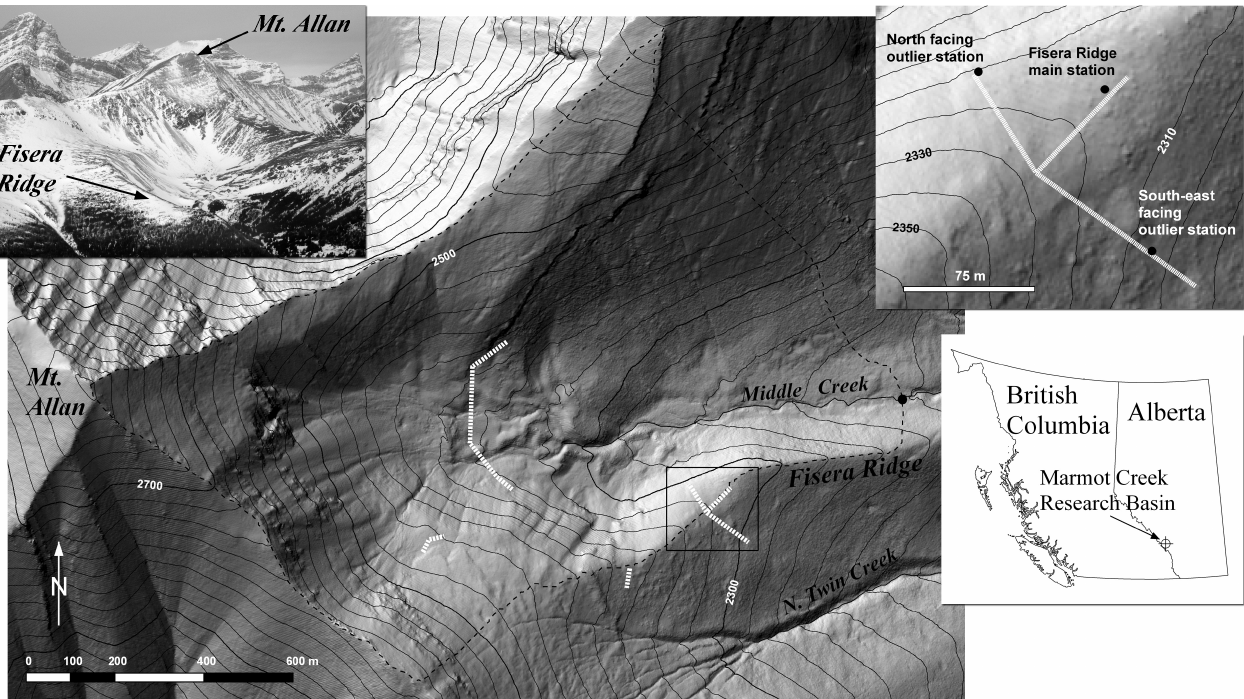
Fig. 1. Shaded topographic map of Fisera Ridge and the Upper Middle Creek Basin within the Marmot Creek Research Basin, Alberta. Snow survey transects in 2008 are represented by the white dashed lines and location of the detailed Fisera Ridge inset map is indicated. Other insets include an aerial photograph of the basin and a map showing the location of Marmot Creek within western